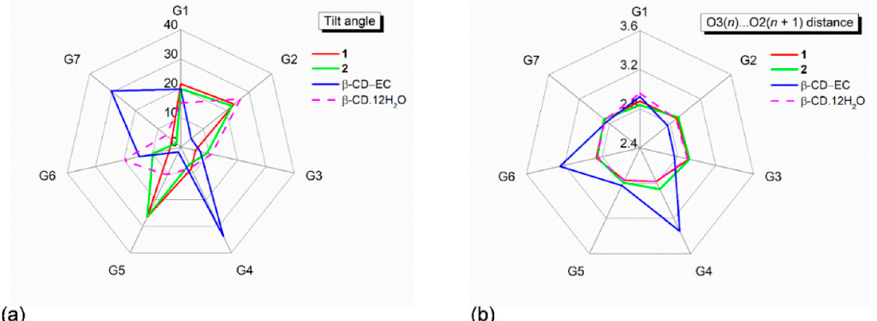
Figure 2. Radar plots of ( a ) tilt angles and ( b ) O3( n ) ∙∙∙ O2( n + 1) distances of the β -CD seven glucose units (G1–G7) affected by inclusion of the aromatic moieties of the CPM B-ring ( 1 ) and the DXP A/B-ring ( 2 ). For comparison, data of the inclusion complex β -CD–( − )-epicatechin(EC) [33] and the uncomplexed β -CD ∙ 12H 2 O [29] are also incorporated. Angles and distances are in ° and Å.